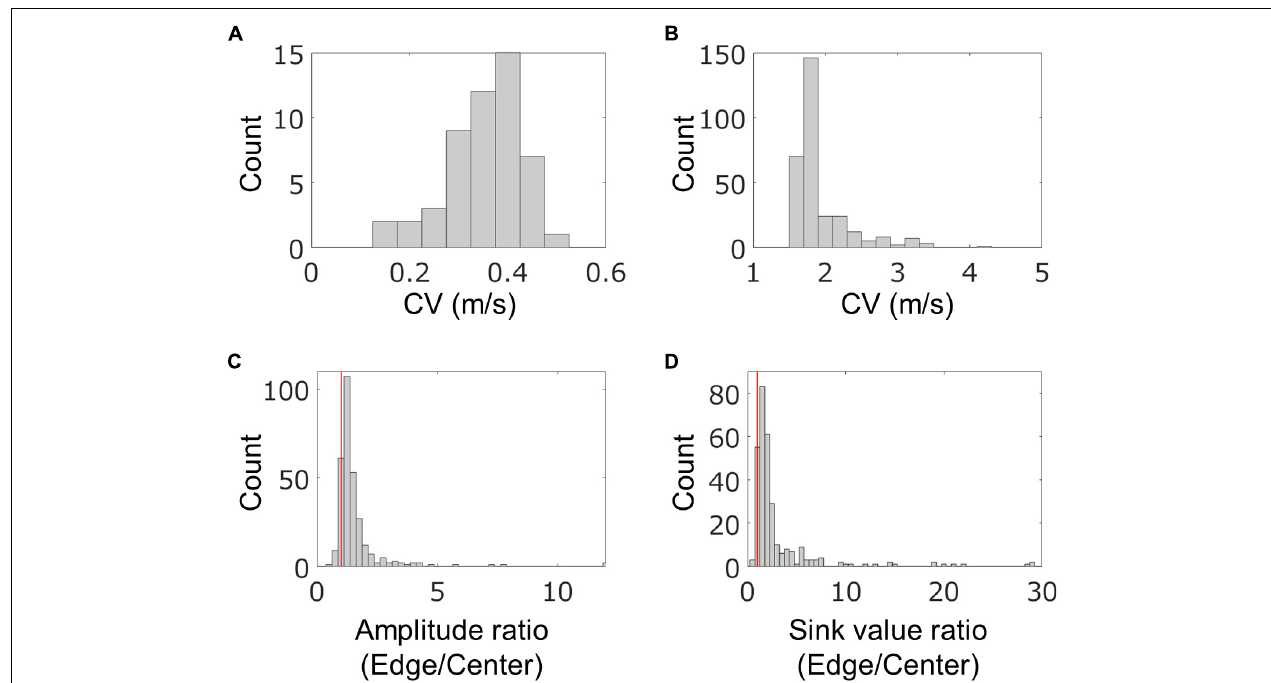
FIGURE 5 | Spatial and temporal characteristics of fast conduction segments. The histograms show conduction velocity (CV) for entire axons (A) and fast conduction segments (B) . Fast conduction segments showed 5.5 times faster conduction. The ratio of the amplitudes (C) and electrical sink (D) between the center and the edge in the fast segment was calculated for evaluating spatial properties. More than 90% of fast conduction segments showed greater value for amplitude and sink at the edge than the center. Red vertical lines are placed at 1 in panels (B,C) . Electrical recording on 58–64